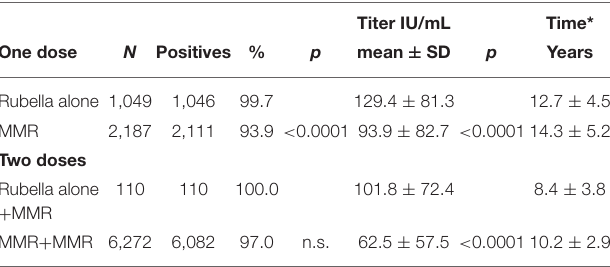
TABLE 4 | Comparative analysis of seropositivity and antibody titer after administration of the vaccine alone or in the MMR formulation. Titer